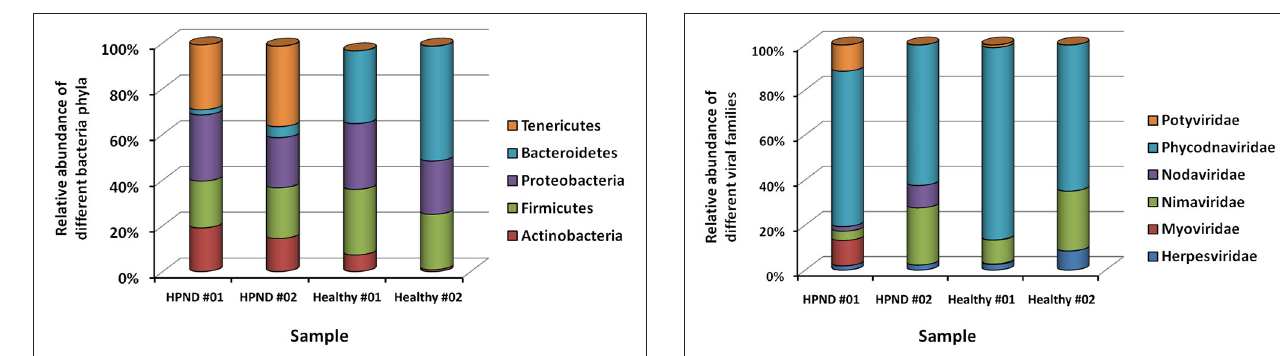
FIGURE 3 | Relative abundance of viruses at the family level in crabs with and without HPND. HPND #01, HPND #02: two samples from crabs with HPND; Healthy #01, Healthy #02: two samples from crabs without HPND.